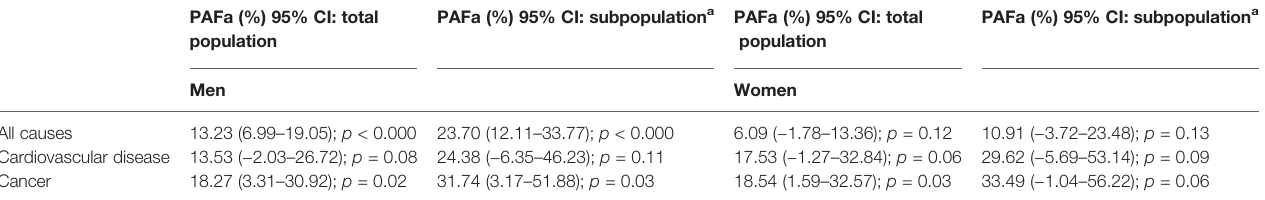
TABLE 5 | Sex-speci fi c PAFs of ABSI to all-cause and cause-speci fi c mortality in the US population. PAFa (%) 95% CI: total